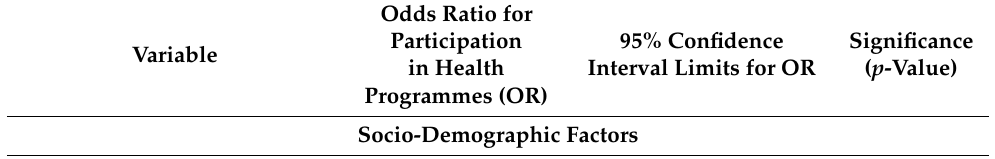
Table 2. Characteristics of respondents vs. participation in health